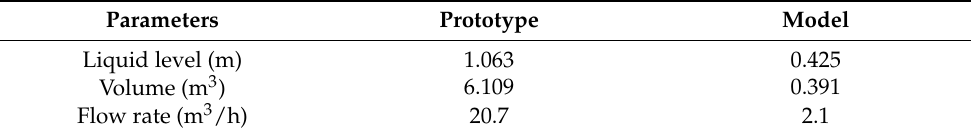
Table 2. Process parameters of prototype and water model of the